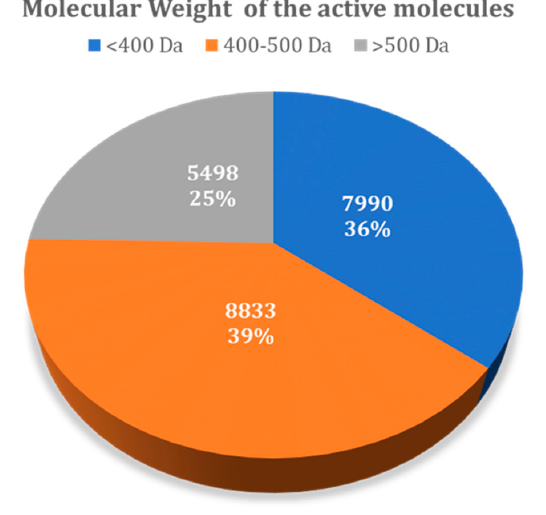
Figure 7. Molecular weight of all active molecules present in the DUD–E database.